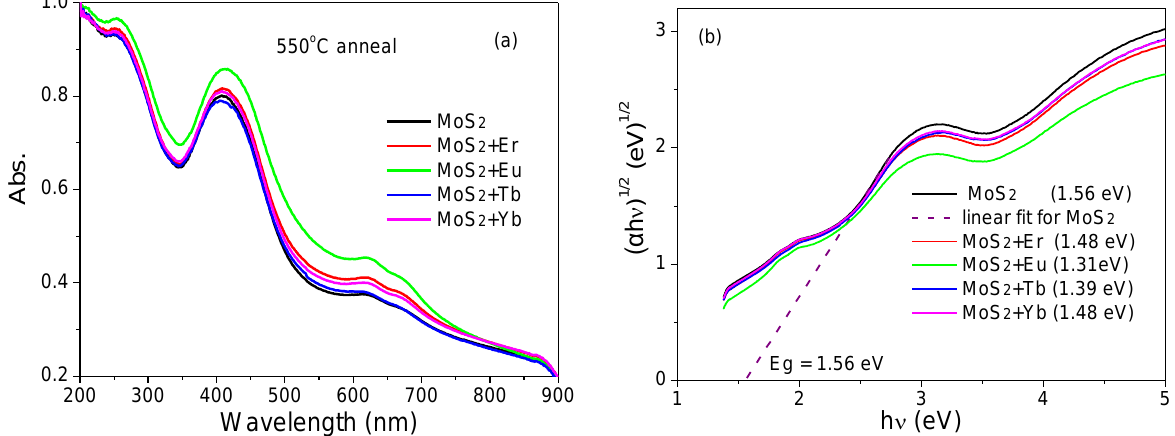
Figure 6. ( a ) Normalized absorption spectra of the samples deposited on Al 2 O 3 substrates after annealing at 550 ◦ C in Ar + 10% H 2 . ( b ) Tauc plot of the spectra, where the bandgaps of the samples were obtained via extrapolating the linear section to the h ν axis.